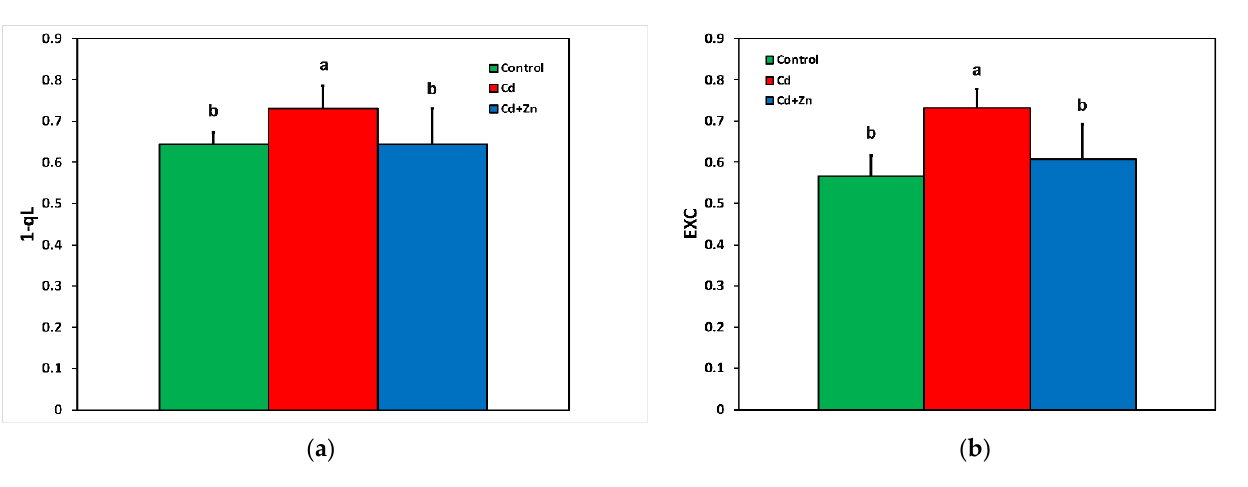
Figure 4. Changes in the redox state of plastoquinone pool based on the lake model (1 − q L ) ( a ), and the excess excitation energy (EXC) ( b ), estimated at 900 µ mol photons m − 2 s − 1 actinic light (AL) intensity, of Salvia sclarea control (nutrient solution), Cd 2+ (nutrient solution +100 µ M Cd 2+ ), and Cd 2+ + Zn 2+ (nutrient solution +100 µ M Cd 2+ + 900 µ M Zn 2+ ). Error bars are standard deviations ( n = 5). Columns with different lowercase letters are statistically different ( p < 0.05).